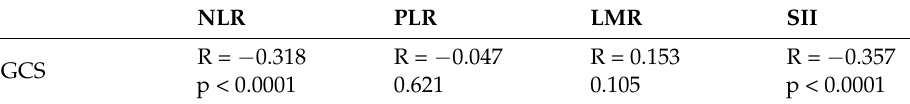
Table 4. Significant correlations between GCS, NLR, PLR, LMR, and SII.